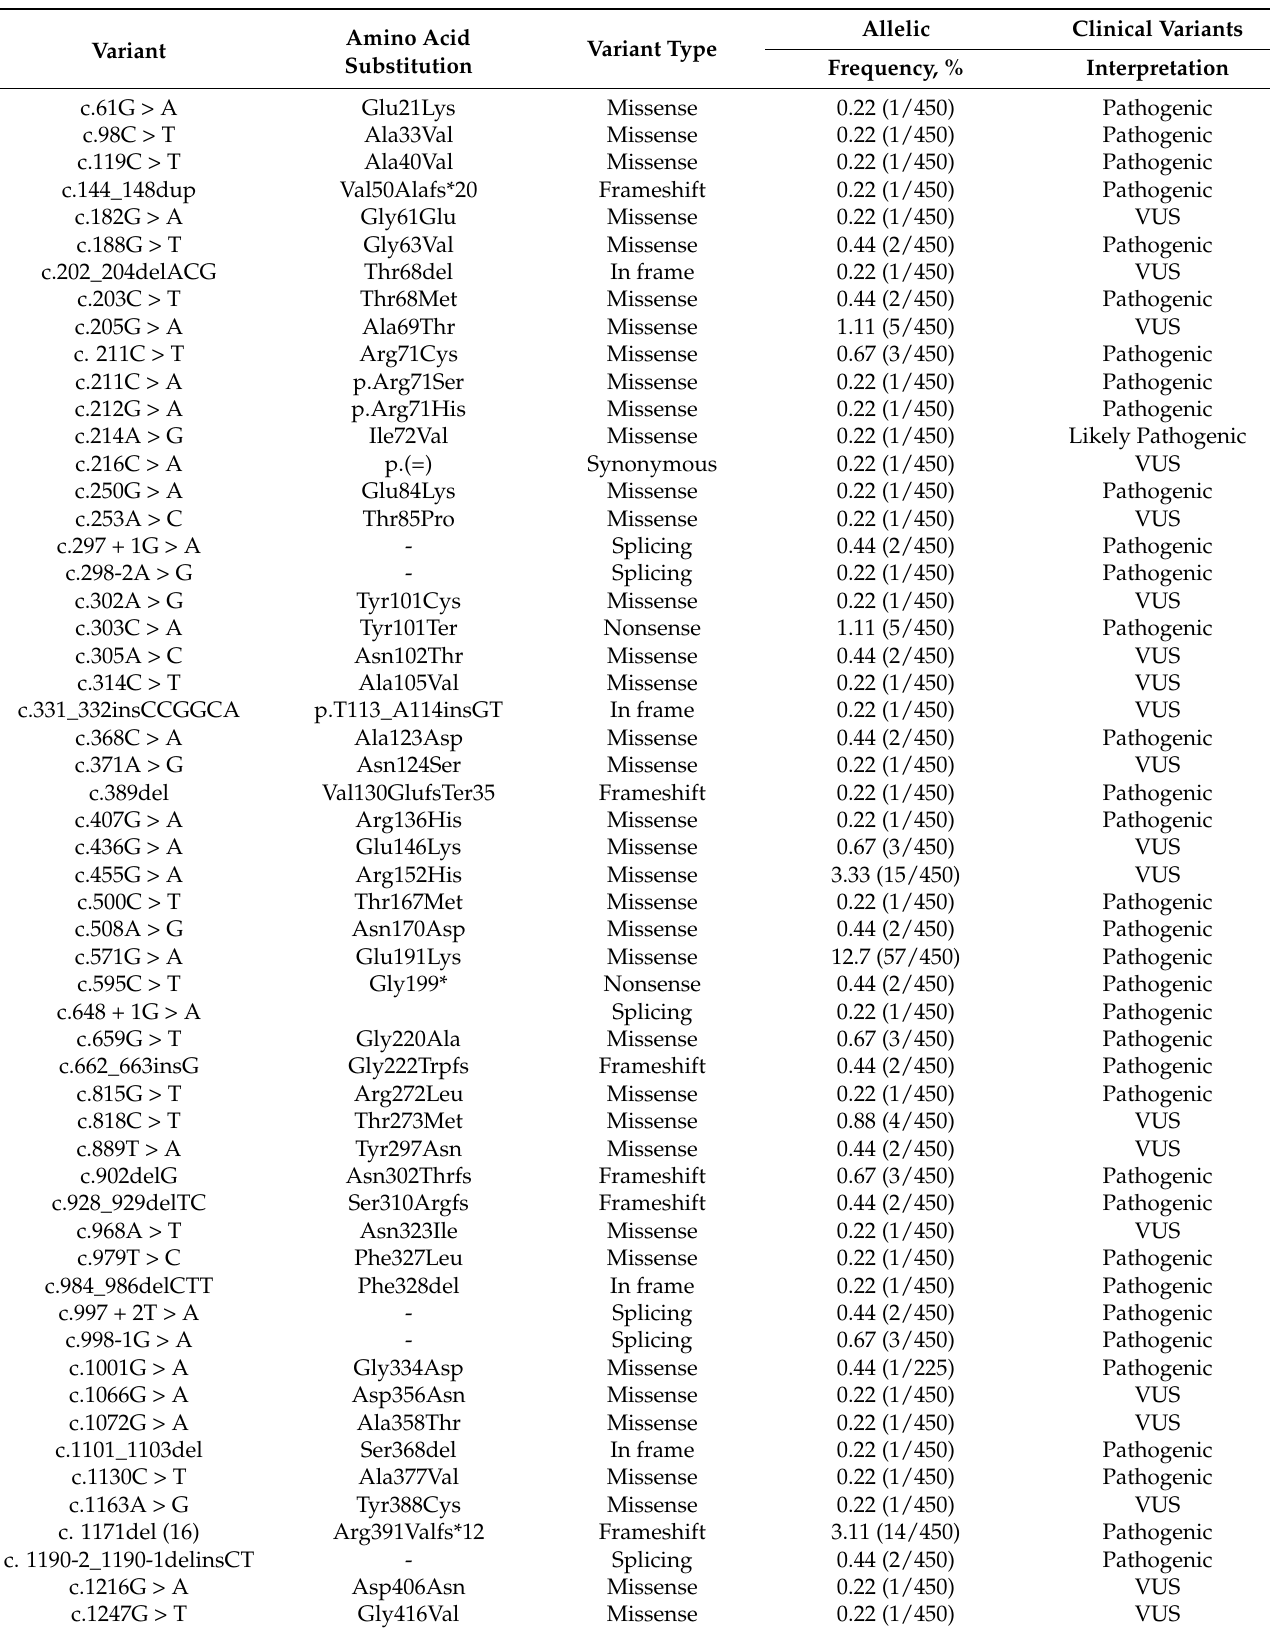
Table 3. Genetic variants of the ALPL gene in 225 heterozygote HPP